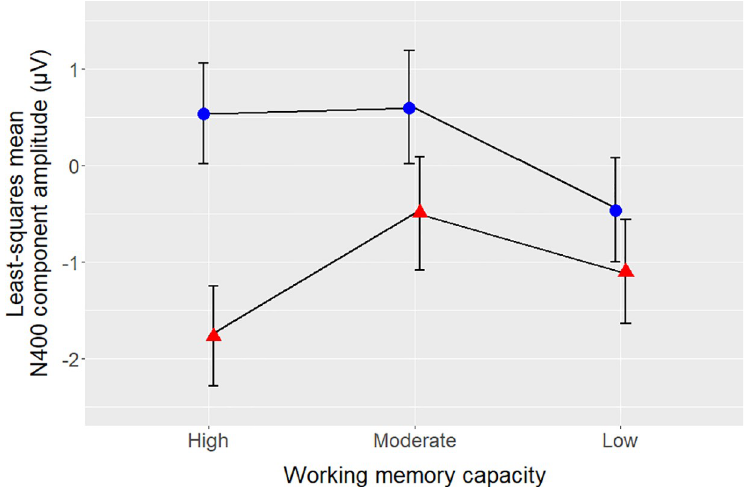
Fig 7. The relationship between N400 component amplitude and working memory capacity. Least-squares mean amplitude values for congruous sentences are shown as blue circles, least-squares mean amplitude values for incongruous sentences are shown as red triangles. Error bars show 95% confidence intervals. High-, moderate- and low-working-memory-capacity groups were defined by digit span scores as used in the post-hoc analysis.